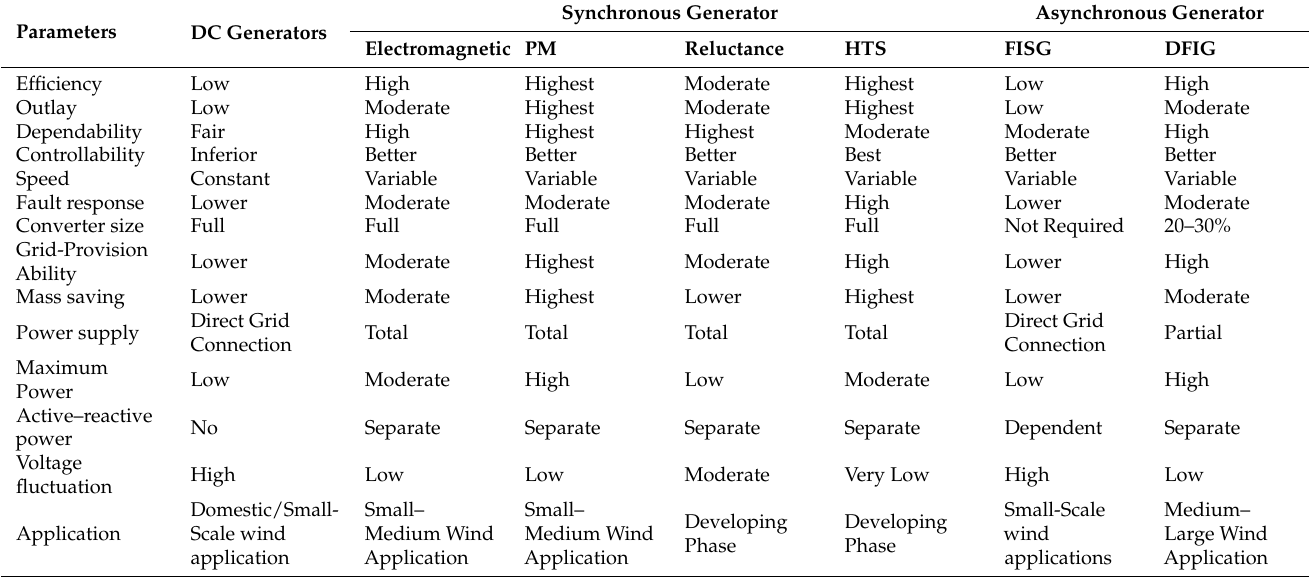
Table 1. Comparison between various WTGs.